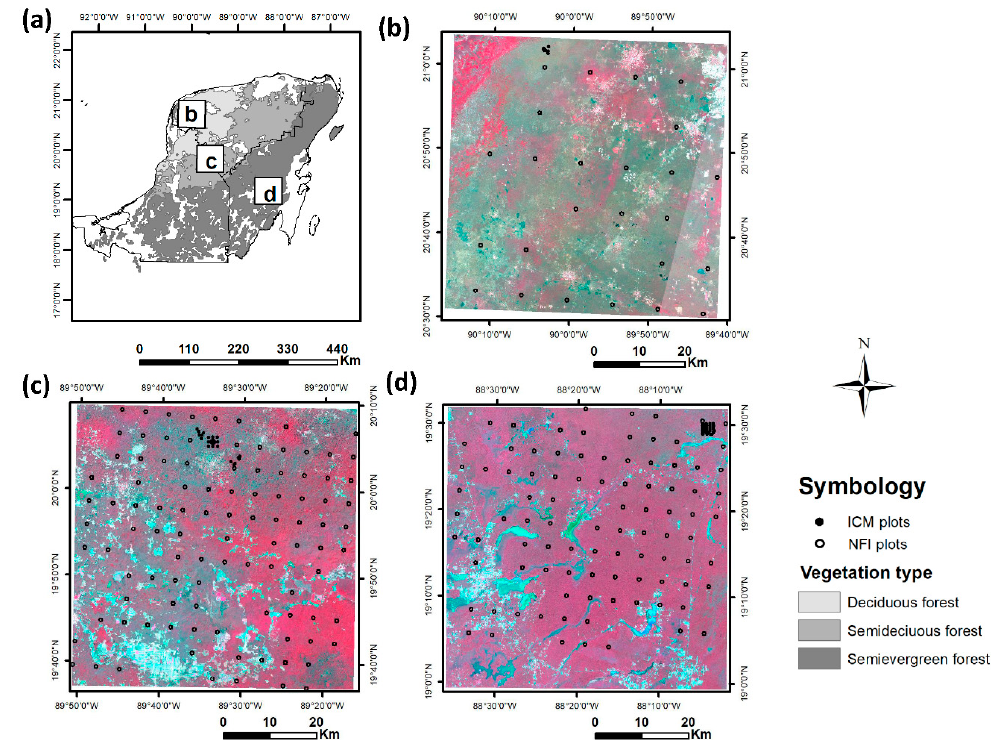
Figure 1. Location of the study area showing the three sites ( a ) as well as the distribution of plots for each type of tropical dry forest: deciduous ( b ), semi-deciduous ( c ), and semi-evergreen forest ( d ) and a false color composite of the study area using green, red, and near-infrared bands from Sentinel-2 imagery. ICM: intensive carbon monitoring, NFI: national forest